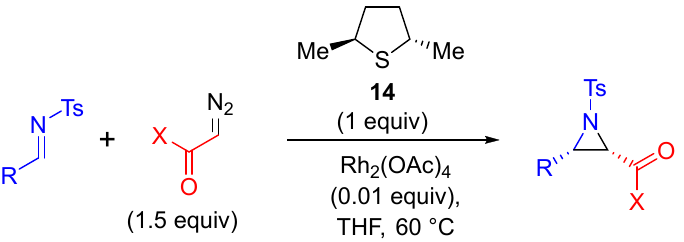
Scheme 27. Asymmetric aziridination of diazoesters and diazoacetamides.